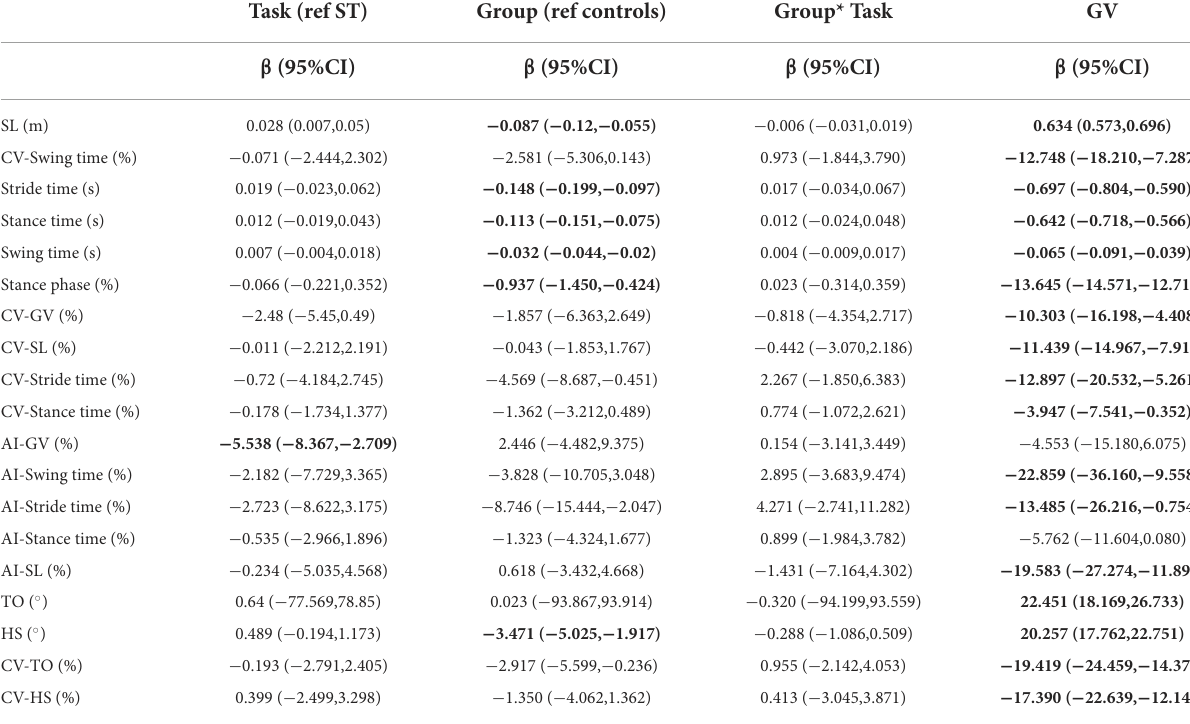
TABLE 2 Results of the generalized linear mixed models for each gait parameter controlling for gait